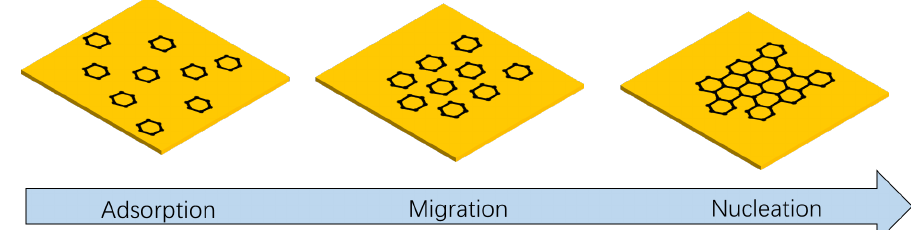
Figure 3. Gas phase reaction of graphene growth from benzene at low temperatures (300~600 °C).